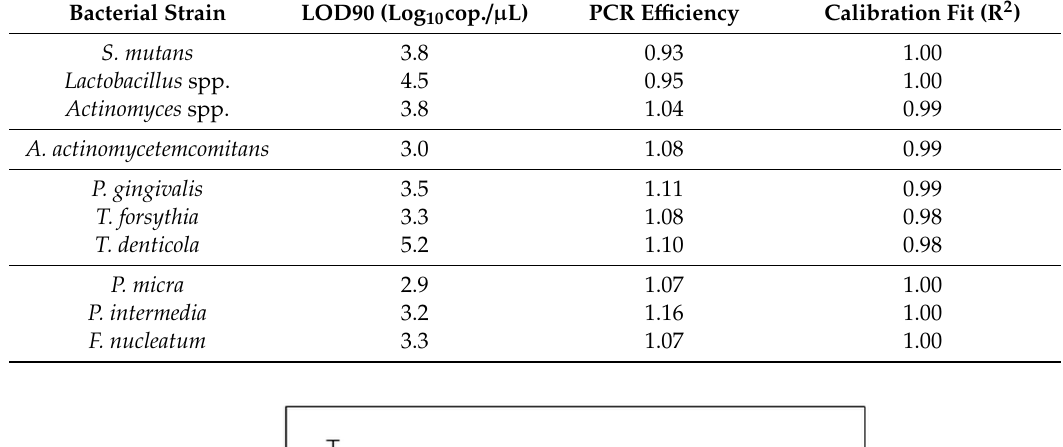
Table 2. Limit of detection (LOD) determined by PROBIT regression analysis (90% confidence level), the e ffi ciency of PCR reaction and R 2 calibration fit values for quadruplex PCR assays.